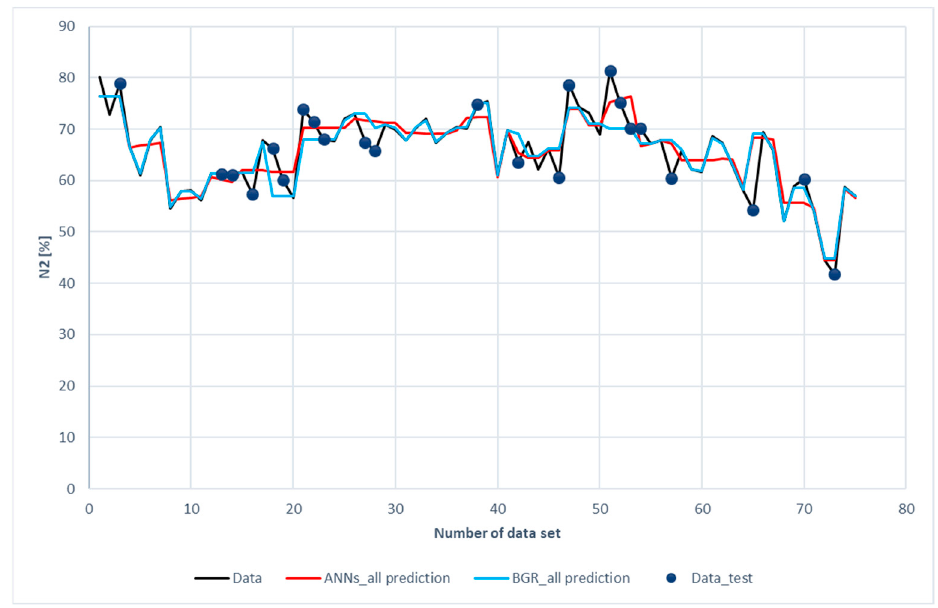
Figure 12. Comparison of N 2 compositions among the experimental data for the ANN and GBR models.